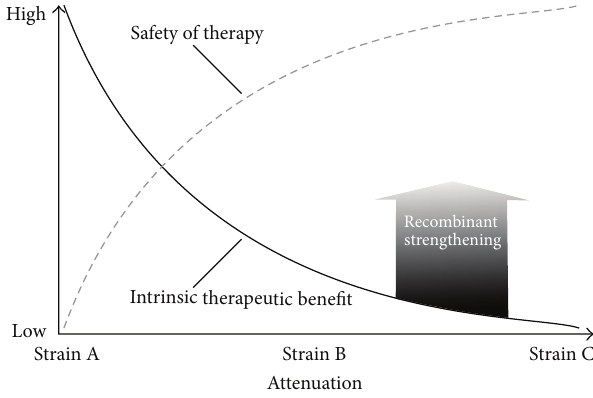
Figure 2: Hypothetical relationship between intrinsic therapeutic benefit and safety using Salmonella for bacteria mediated tumor therapy. Empirical observations support an inverse relationship between intrinsic therapeutic benefit and safety of treatment asso- ciated with Salmonella -based tumor therapy. Strain variants A–C in order of increased attenuation. Depicted are three scenarios, each intrinsically inadequate for achieving therapeutic